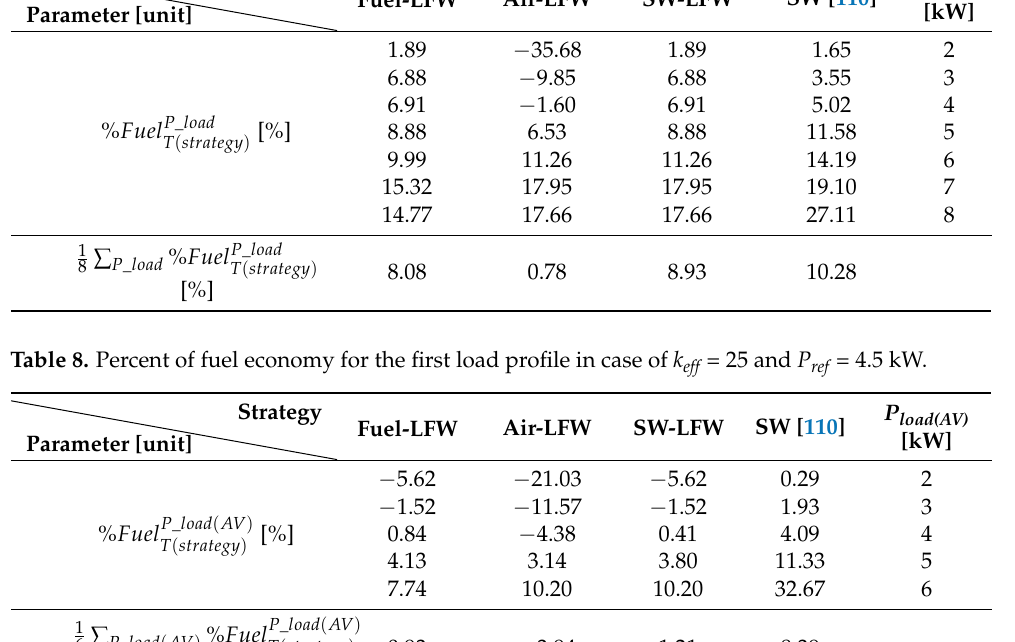
Table 7. Percent of fuel economy for different P load values in case of k eff = 25 and P ref = 4.5 kW. Strategy Fuel-LFW Parameter [unit]